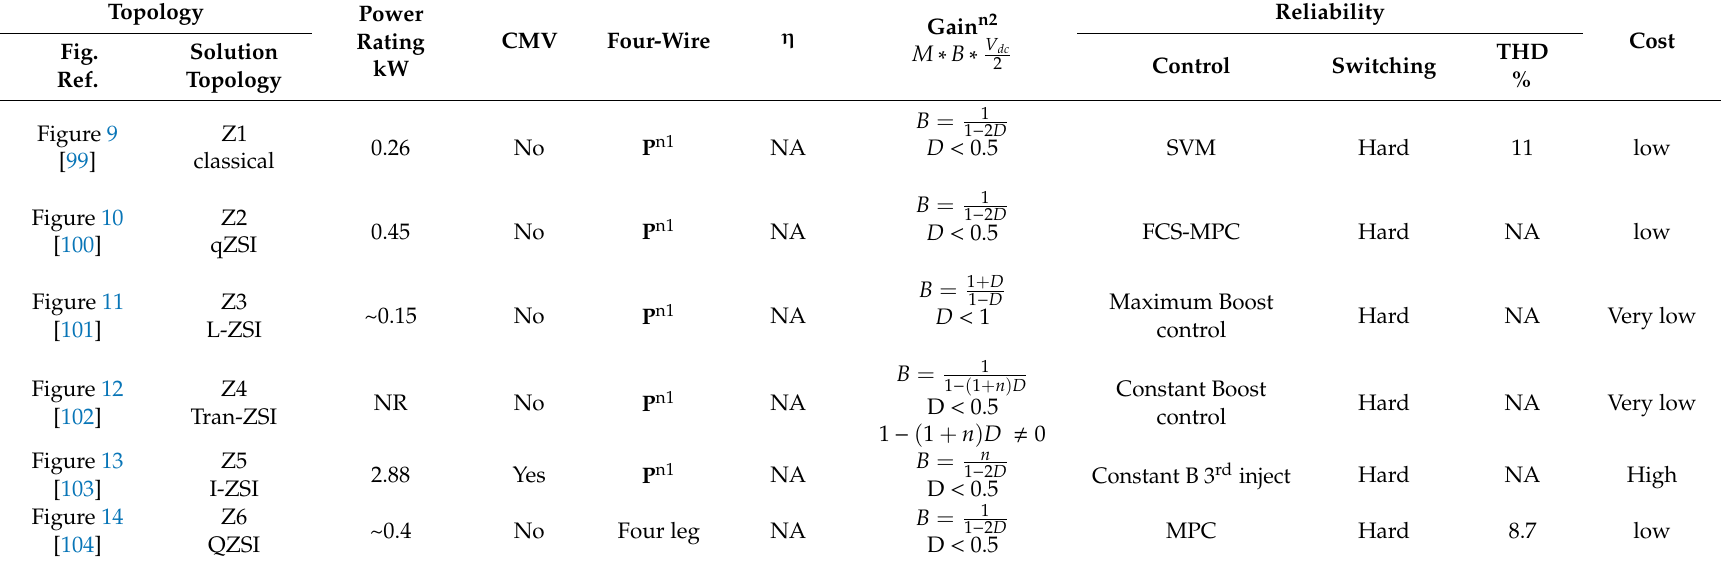
Table 3. Performance comparison for selected topologies of Z-source